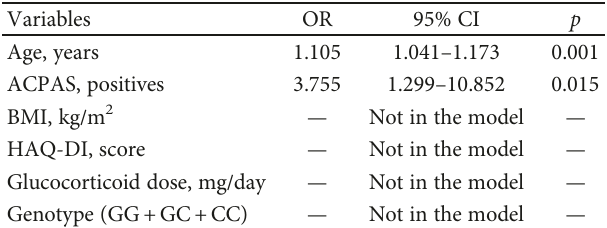
Table 4: Factors associated with low bone mineral density in the logistic